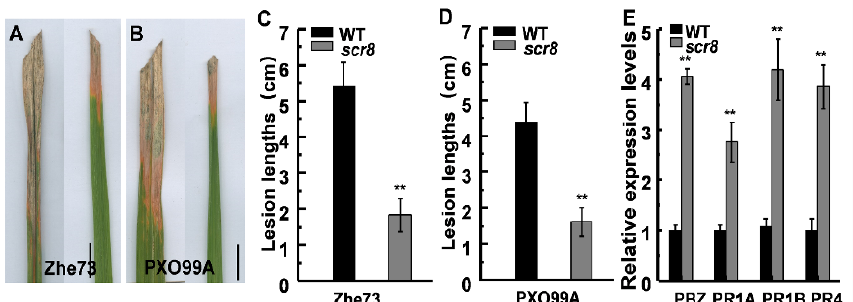
Figure 8. scr8 induced pathogenesis-related genes and disease resistance. ( A ) Leaf phenotype of WT and scr8 after inoculation with Zhe173. Scale bar, 1cm. ( B ) Leaf phenotype of WT and scr8 after inoculation with PXO99A. Scale bar, 1cm. ( C ) Lesion length after inoculation Zhe173. ( D ) Lesion length after inoculation PXO99A. ( E ) Relative expression levels of pathogenesis-related genes in WT and scr8 plants at heading stage. Error bars represent SD. ** Significant difference at p < 0.01 compared with the WT by Student’s t -test.